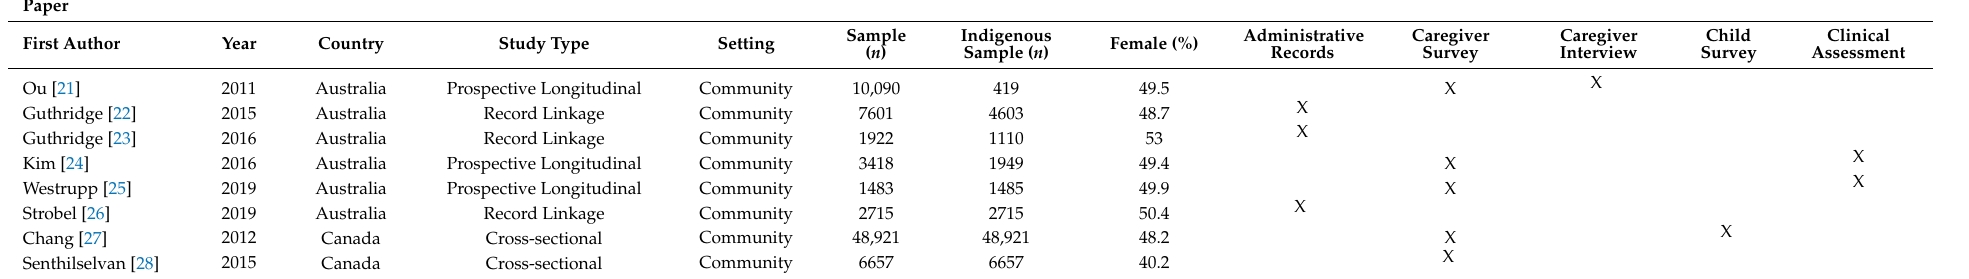
Table 1. Summary of included papers ( n = 8).